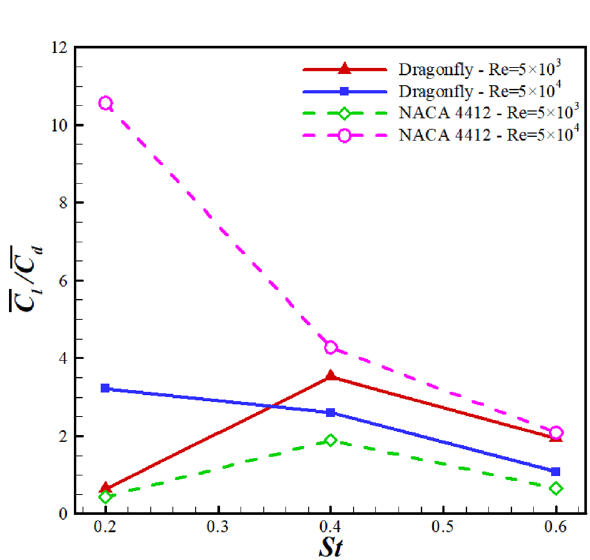
Figure 18. The mean aerodynamic performance variations in different St